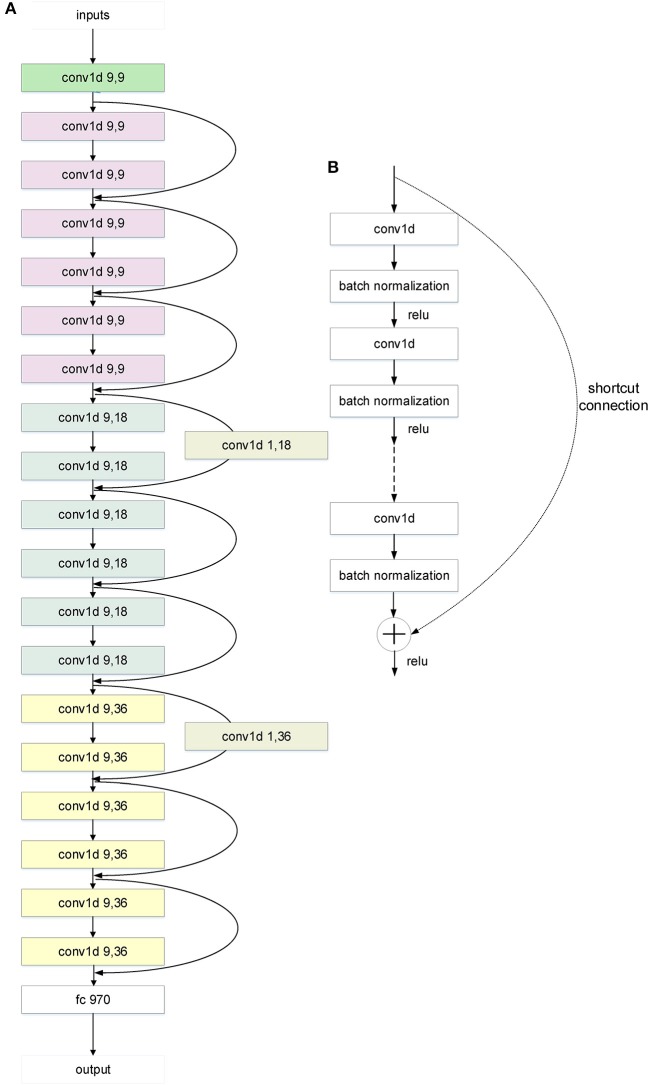
The architecture of the 20-layer CNN ResNet-like deep learning model. (A) A CNN ResNet-like deep learning model with 20 parameter layers. The “conv1d x,y” is a 1D convolution layer with x kernel sizes and y filters. And the curvy arrows are the shortcut connections. The shortcut connection with a parameter layer increases dimensions. The different color means different layer class in the architecture. “Green” means the first layer, “white” means the last layer, “gray” means the parameter layer of the shortcut connection, and the others mean the residual layers. The color change of the residual layers from purple to blue to yellow indicates the tensor dimension change from 9 to 18 to 36. (B) The shortcut connection in the architecture of CNN ResNet-like deep learning model. Shortcut connections simply perform identity mapping by skipping one or more layers (20). Their outputs are added to the outputs of the stacked layers without extra parameter and computational complexity.